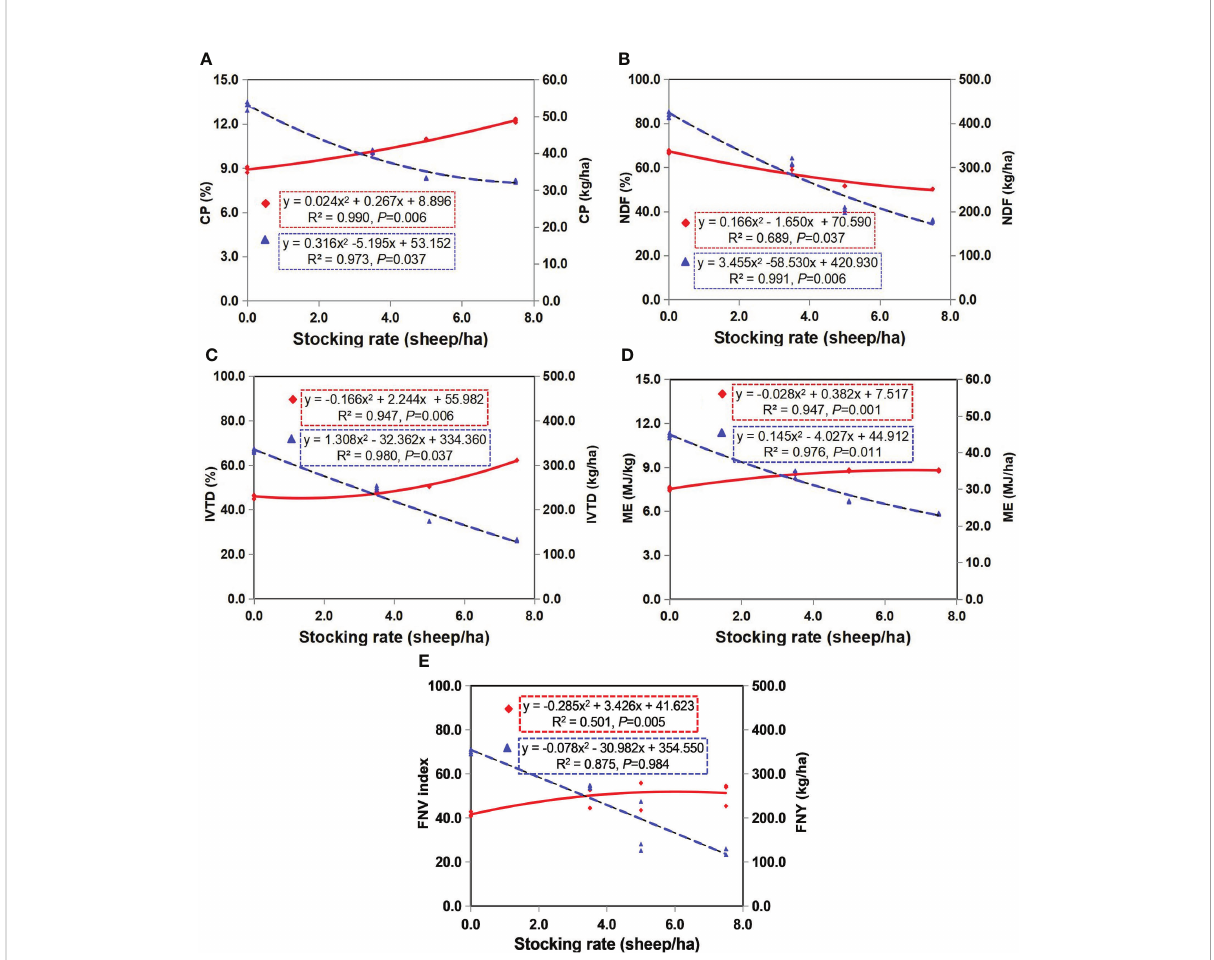
FIGURE 6 Relationship between stocking rate and forage nutritive value (FNV; left y-axis, %) and forage nutritive yield (FNY; right y-axis, kg ha -1 ) for four dominant species in two years (2019 and 2020): (A) crude protein (CP), (B) in vitro true dry matter digestibility (IVTD), (C) neutral detergent fi ber (NDF), (D) metabolizable energy (ME) and (E) forage nutritional value (FNV). Solid lines denote concentrations ( ♦ ), and long-dashed regression lines denote yields of herbage nutritional parameters ( ▲ ) (yields = concentrations × dry matter of above-ground